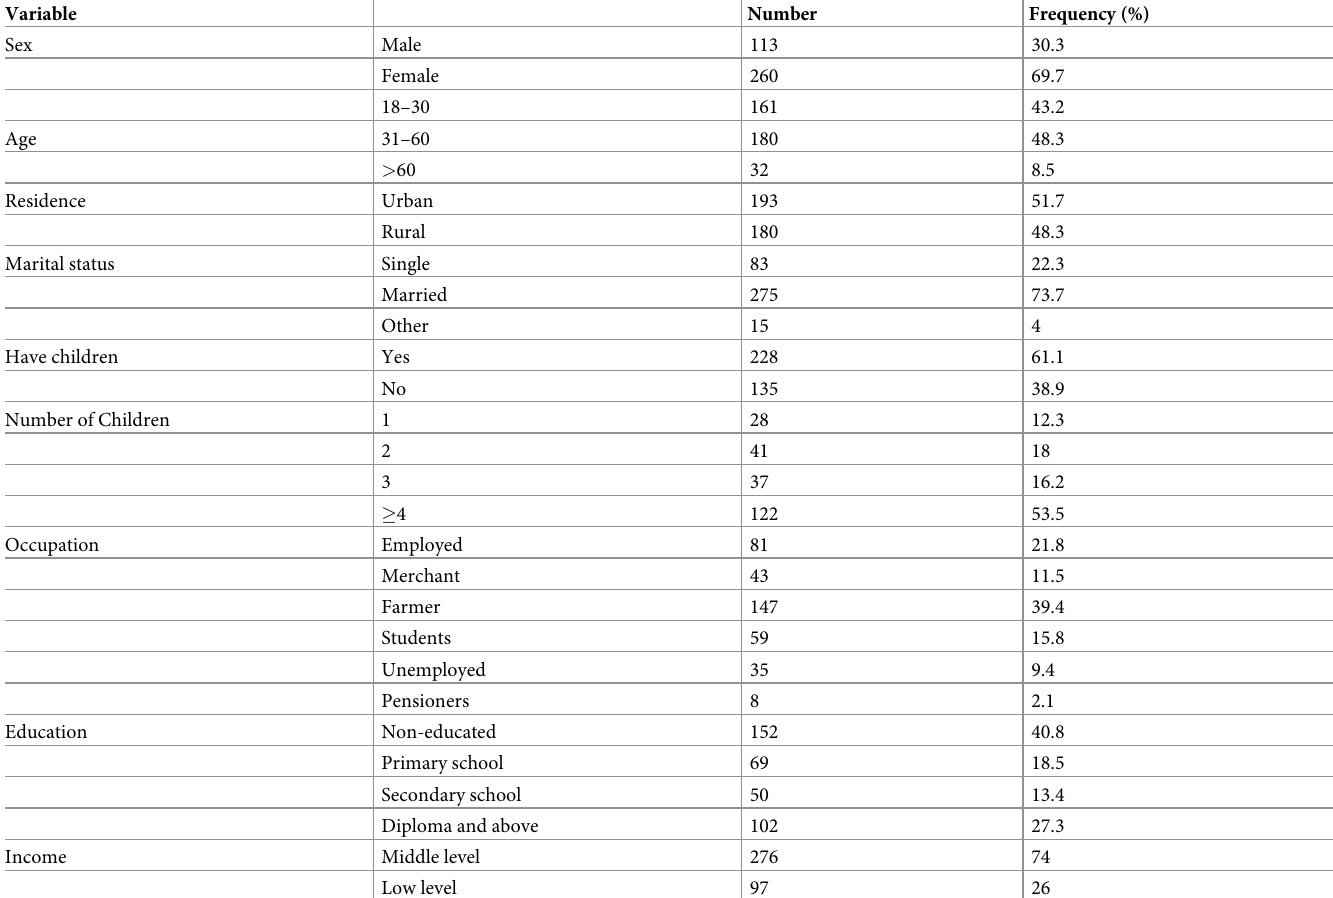
Table 1. Socio-demographic characteristics of study participants at DTCSH, Northwest Ethiopia, 2020.